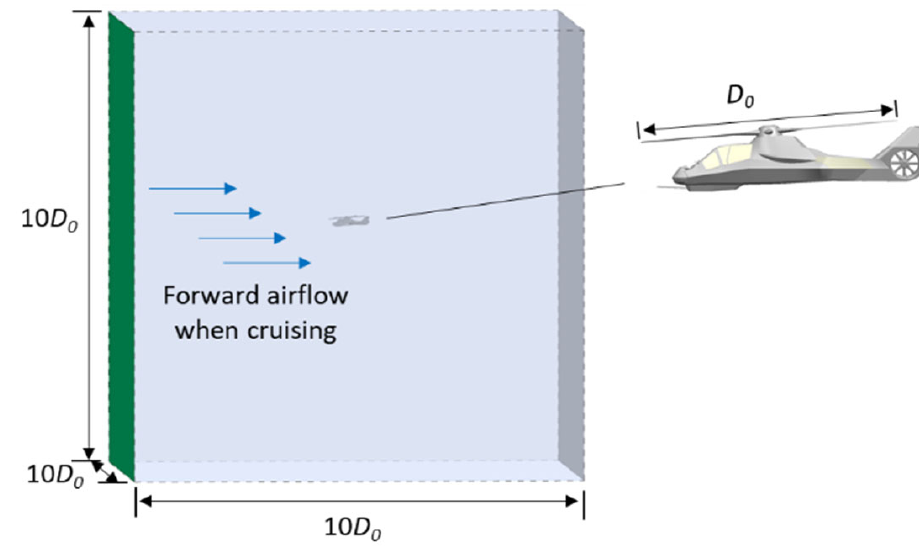
Figure 2. Computational